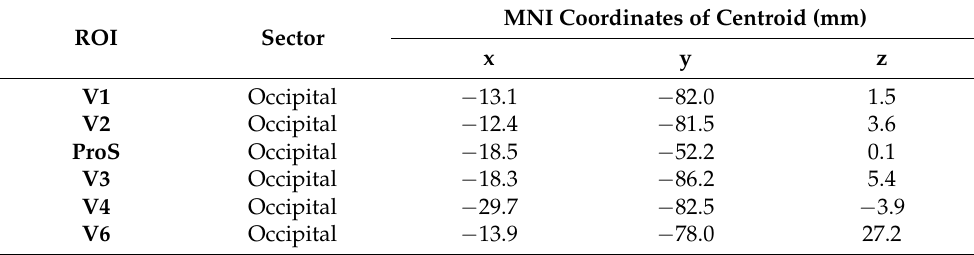
Table 1. List of Region of Interest (ROI) defining the three sectors. A brief description (from van Essen) and the coordinate of the centroid in mm with respect to the template MNI space is reported. MNI Coordinates of Centroid (mm) ROI Sector x y V1 Occipital − 13.1 V2